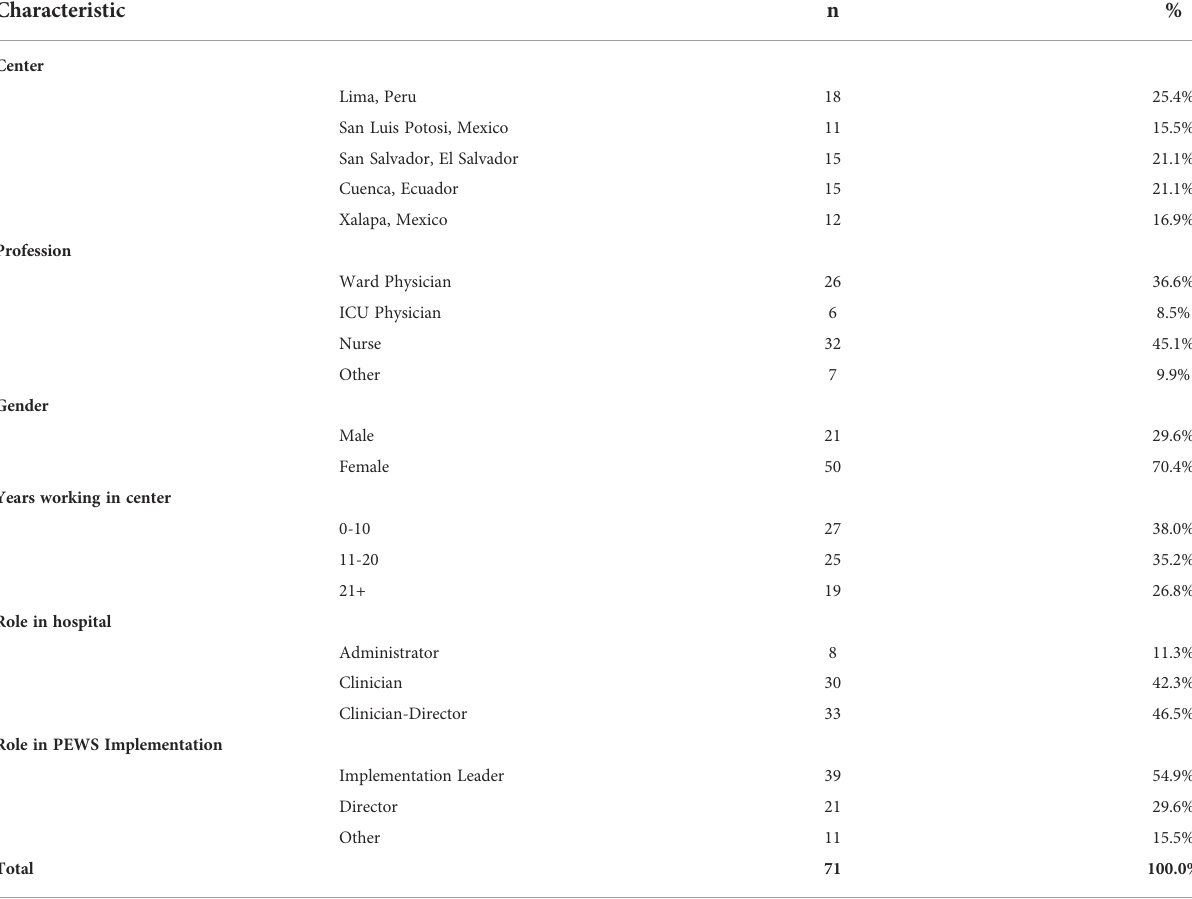
TABLE 1 Characteristics of interview